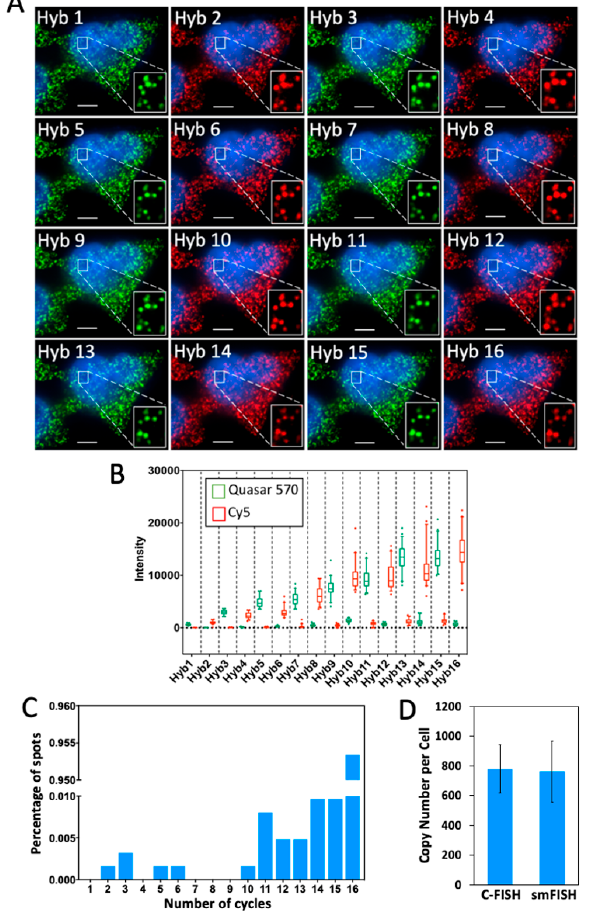
Figure 3. ( A ) GAPDH transcripts in HeLa cells are detected in 16 cycles of C-FISH. Quasar 570 and Cy5 labeled decoding probes were used in the odd and even hybridization cycles, respectively. ( B ) Intensity distribution of the GAPDH transcripts ( n = 45 spots) in 16 cycles of C-FISH. In each cycle, the signal intensities in Quasar 570 and Cy5 channels are shown in green and red, respectively. ( C ) Fraction of GAPDH spots ( n = 1000 spots) appear in different number of C-FISH cycles. ( D ) Comparison of the GAPDH mean copy number per cell ( n = 30 cells) of transcripts measured by C-FISH and conventional single molecule FISH (smFISH) ( p > 0.58). Scale bars, 5 µm.